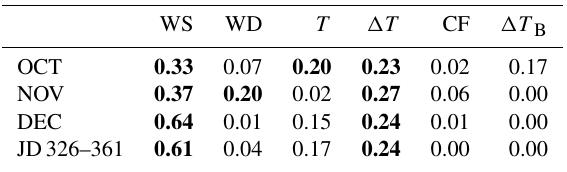
Table A3. Regression ( r 2 ) of meteorological variables with BLD, October–December 1993 (no radiation data in 1993). Bolding is the same as in Table A1. WS WD T (cid:49)T CF (cid:49)T B